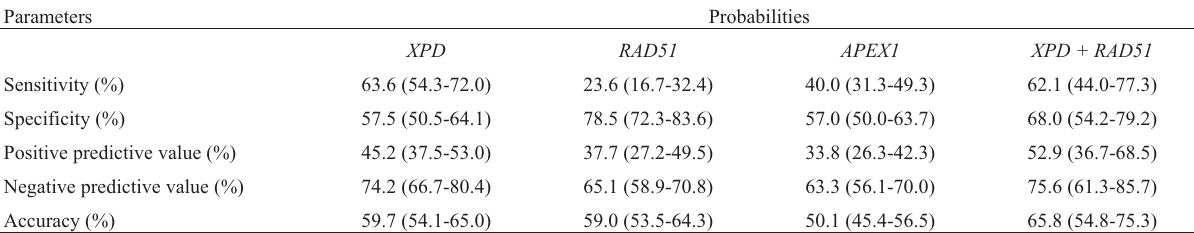
Table 4 - Data performance diagnostic test calculated for each polymorphism alone and combined